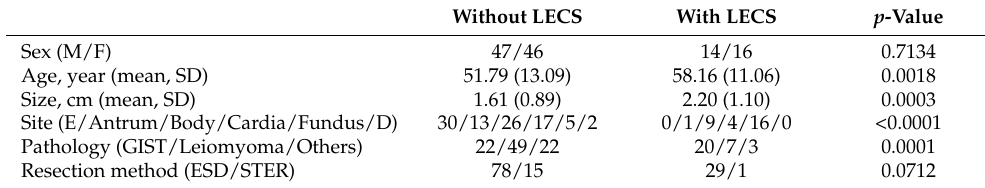
Table 3. Comparison of patient features with or without LECS.